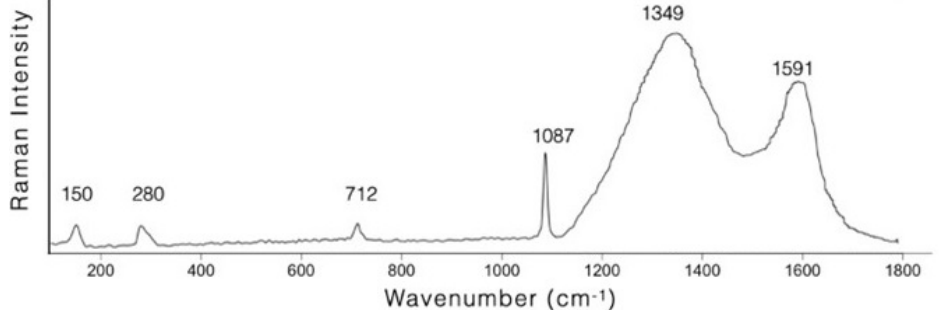
Figure 7. Representative baseline-subtracted Raman spectrum of sample 26. Acquisition parameters: 633 nm laser, 50X LWD objective, 0.6 mW, 3600 s. Table 3. EDS microanalysis ( w / w %) of pigment layer and the Ca-based layer of sample 1.